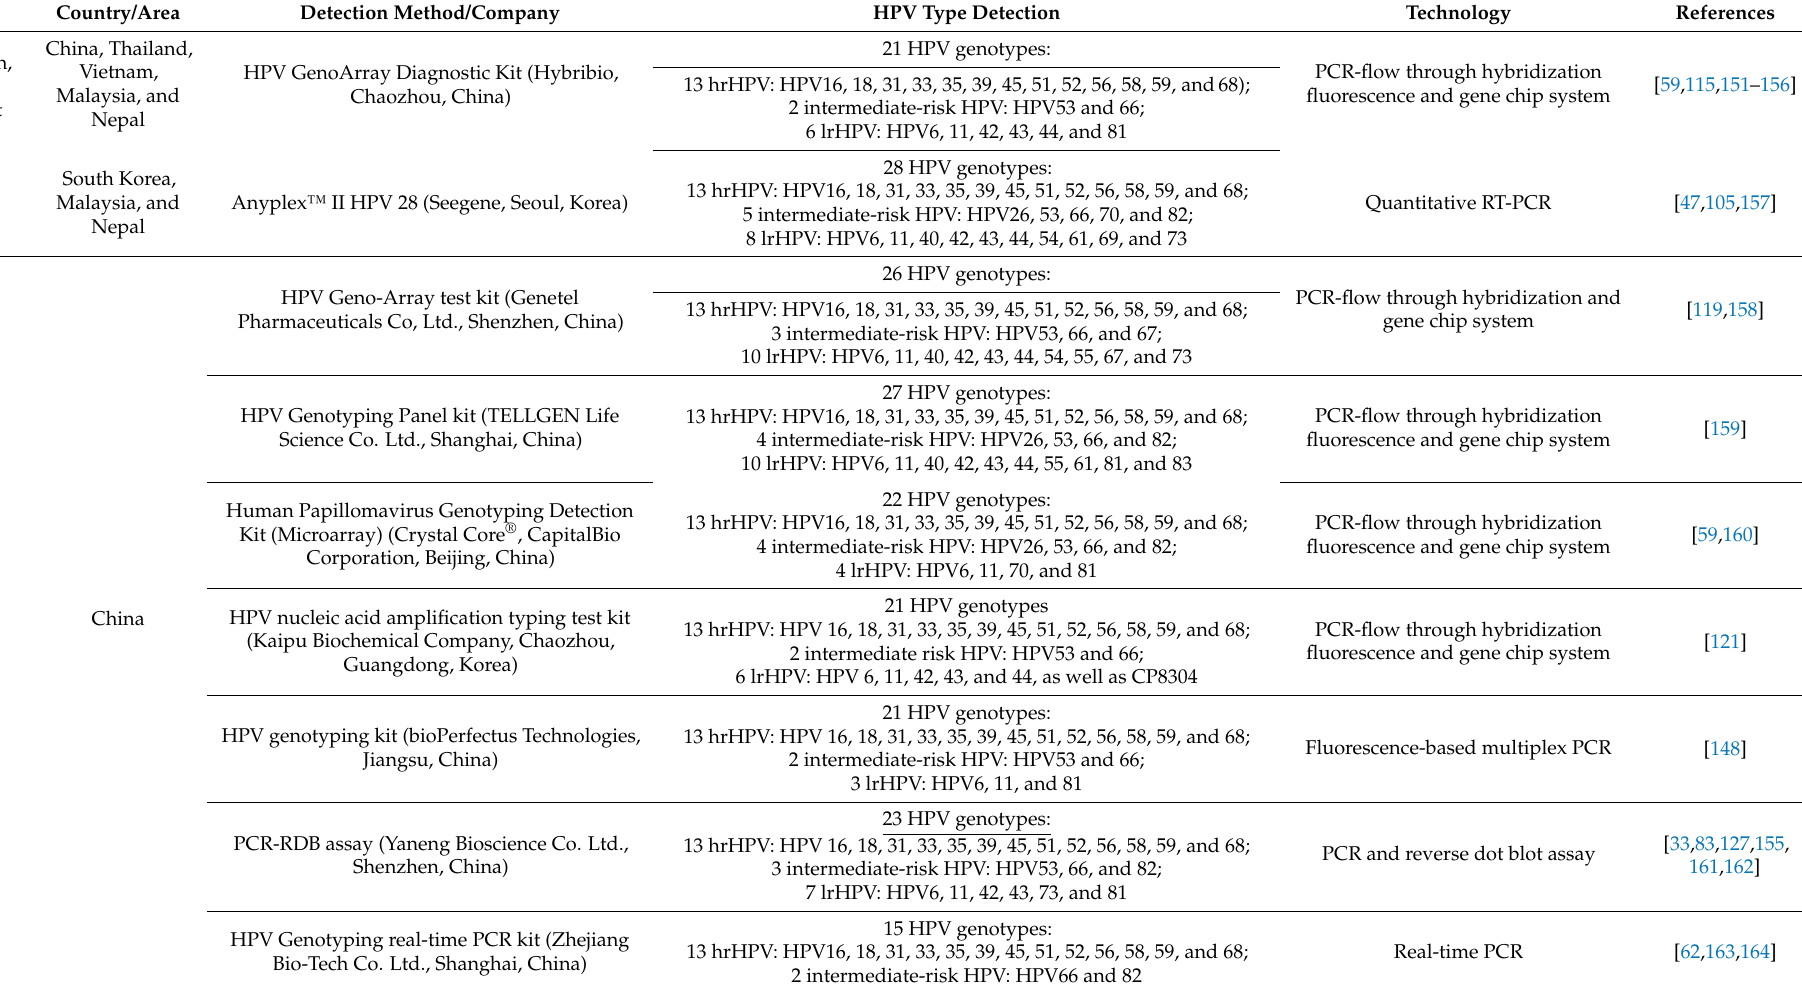
Table 6. The commercial HPV nucleic acid detection systems used in East, Southeast, and South